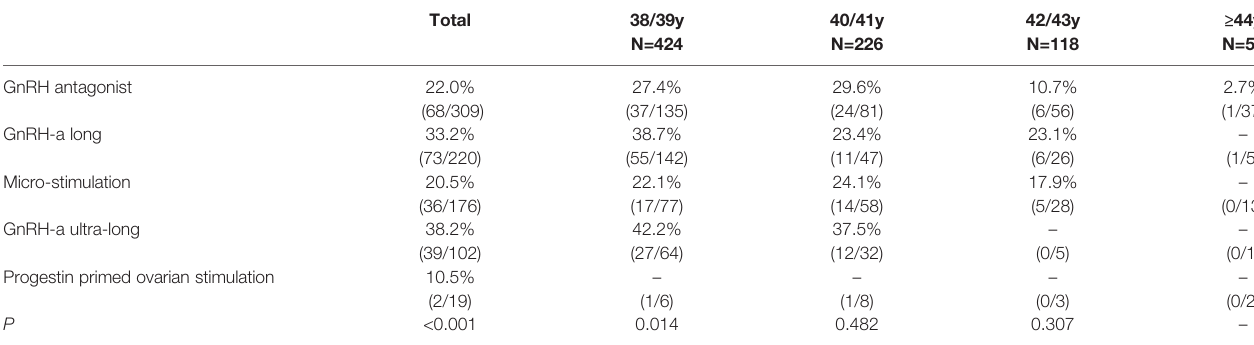
TABLE 3 | Cumulative live birth of different ovarian stimulation protocols in different age brackets.-, not analyzed since the number of the subjects is